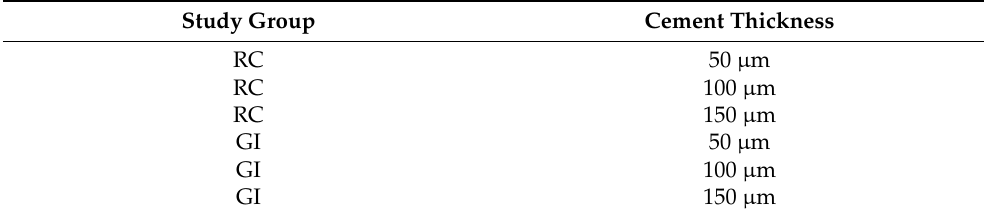
Table 1. Mechanical properties of tissues and materials used in 3D finite element stress analysis models of maxillary molars. Table 2. Study groups.